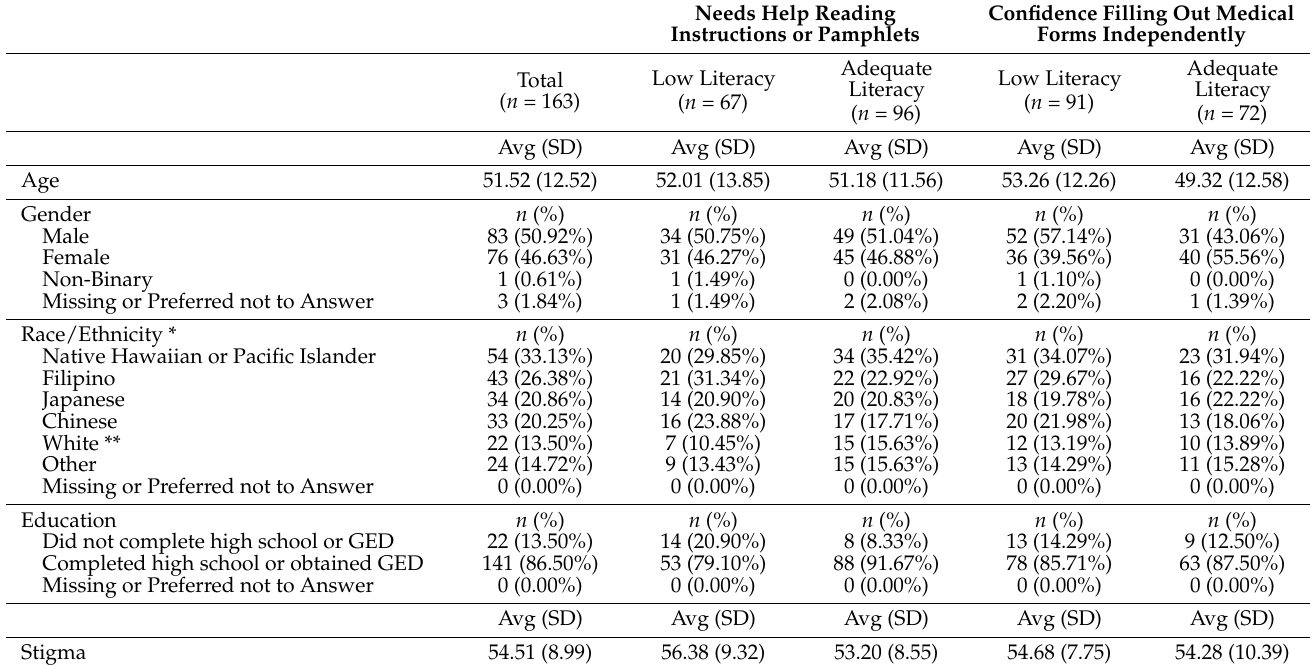
Table 1. Participant Characteristics and Average Health